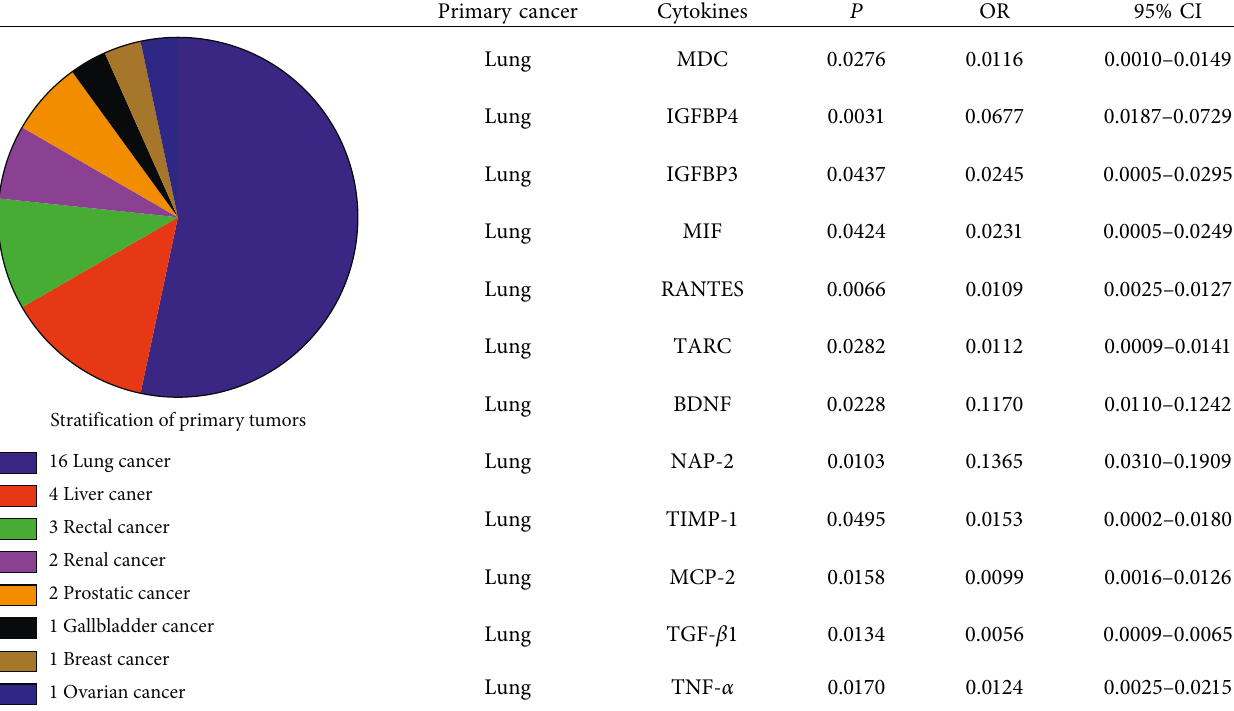
Table 4: Relationship between cytokines and primary cancer preradiotherapy and